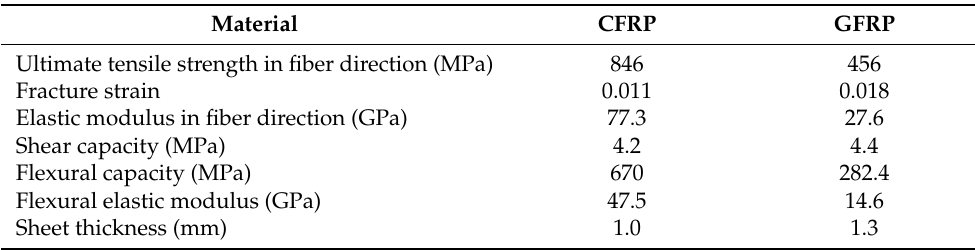
Table 1. Mechanical characteristics of FRP